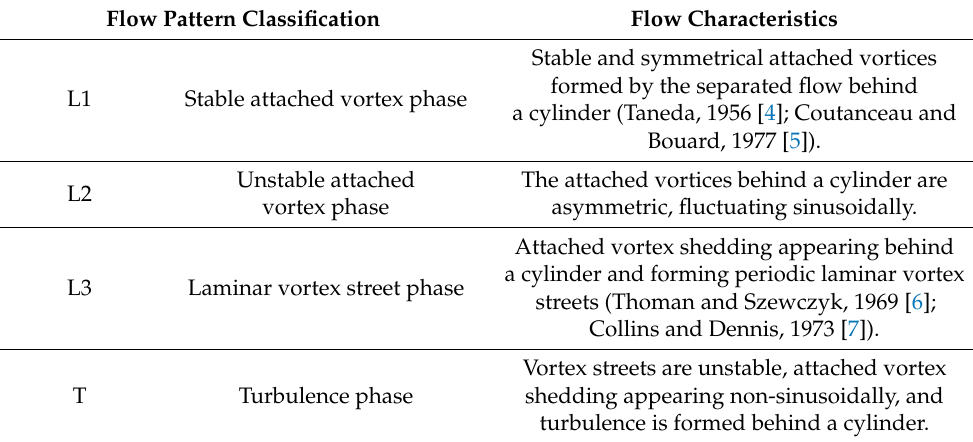
Table 1. An overview of the flow pattern classifications of the flow around a square cylinder. Flow Pattern Classification Flow Characteristics Stable and symmetrical attached vortices formed by the separated flow behind L1 Stable attached vortex phase a cylinder (Taneda, 1956 [4]; Coutanceau and Bouard, 1977 [5]). Unstable attached The attached vortices behind a cylinder are L2 vortex phase asymmetric, fluctuating sinusoidally. Attached vortex shedding appearing behind a cylinder and forming periodic laminar vortex L3 Laminar vortex street phase streets (Thoman and Szewczyk, 1969 [6]; Collins and Dennis, 1973 [7]). Vortex streets are unstable, attached vortex T Turbulence phase shedding appearing non-sinusoidally, and turbulence is formed behind a